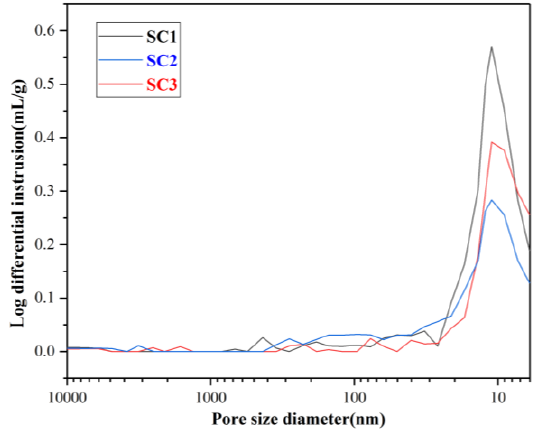
Figure 11. Pore size distribution of samples SC1 - SC3 at 3 days of age.